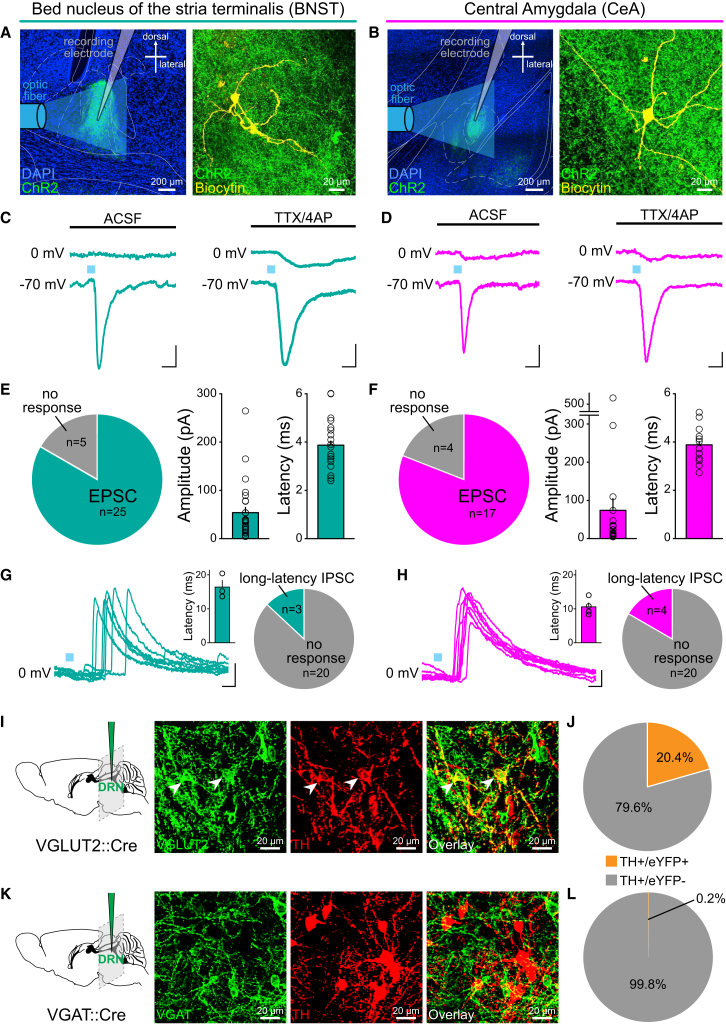
Optical Stimulation of DRN DA Neurons Elicits Monosynaptic Glutamate Release in the BNST and CeA(A) Ex vivo electrophysiology was performed in the BNST and (B) CeA following Cre-dependent expression of ChR2 in the DRN of TH::Cre and DAT::Cre mice.(C and D) Optical stimulation of ChR2-expressing terminals with a 5 ms blue light pulse elicited a short-latency, fast EPSC (measured in voltage-clamp at −70 mV), which persisted in the presence of TTX/4AP, but no detectable short-latency IPSC (measured at 0 mV). Scale bars, 10 pA, 10 ms.(E) The proportion of recorded neurons in the BNST and (F) CeA that responded with an EPSC (in the absence of TTX/4AP) and the amplitude and latency of each.(G and H) Individual traces showing the long-latency IPSCs elicited by successive 5 ms pulses of blue light, delivered every 20 s. Insets show average IPSC latency; pie charts show the proportion of cells which responded with an IPSC. Scale bars, 50 pA, 10 ms.(I and J) Confocal images showing eYFP-expressing neurons (green) in the DRN with post hoc immunohistochemistry for TH (red), following Cre-dependent expression of eYFP, in VGLUT2::Cre and (K and L) VGAT::Cre mice. White arrows indicate selected co-labeled cells. A significantly greater proportion of TH+ neurons co-expressed VGLUT2 (n = 119/582 neurons) compared with VGAT (n = 1/577 neurons; Chi-square = 128.30, p < 0.0001).Data are represented as mean ± SEM. See also Figure S4.